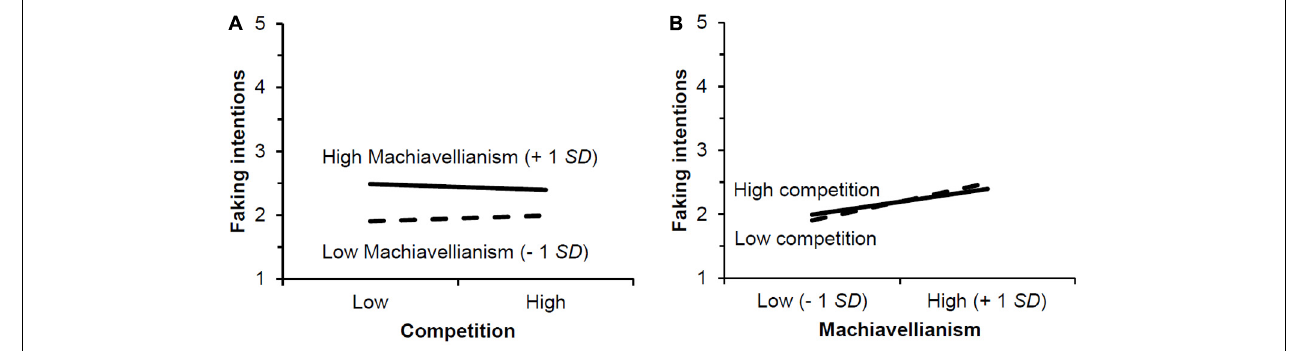
FIGURE 1 | Graphical illustration of the interaction between competition and Machiavellianism. Panel (A) shows simple slopes for Machiavellianism as the moderator and (B) shows simple slopes for competition as the moderator.